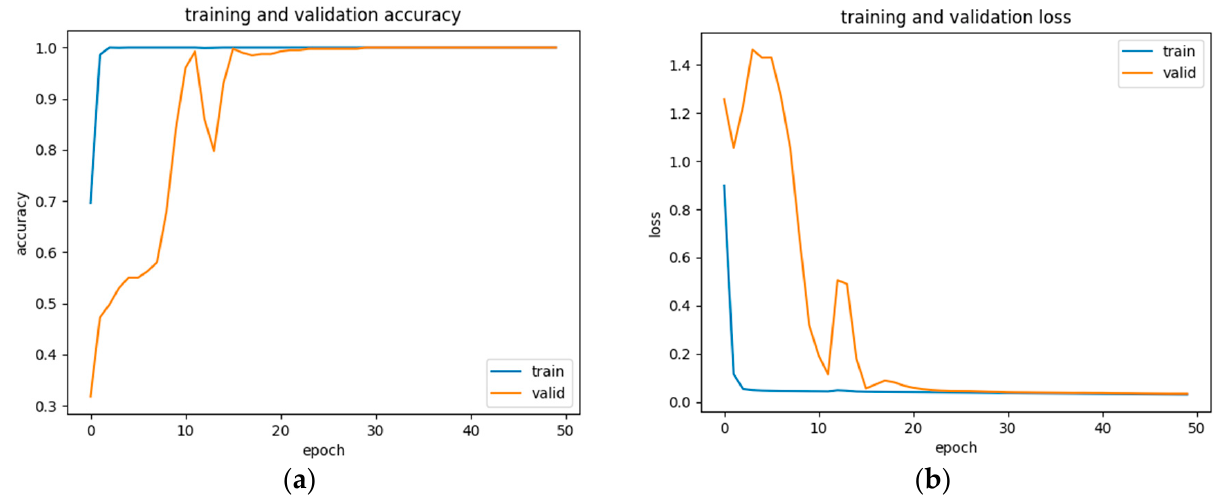
Figure 15. ( a ) Accuracy of the SR − 1DCNN model; ( b ) Loss of the SR − 1DCNN model.